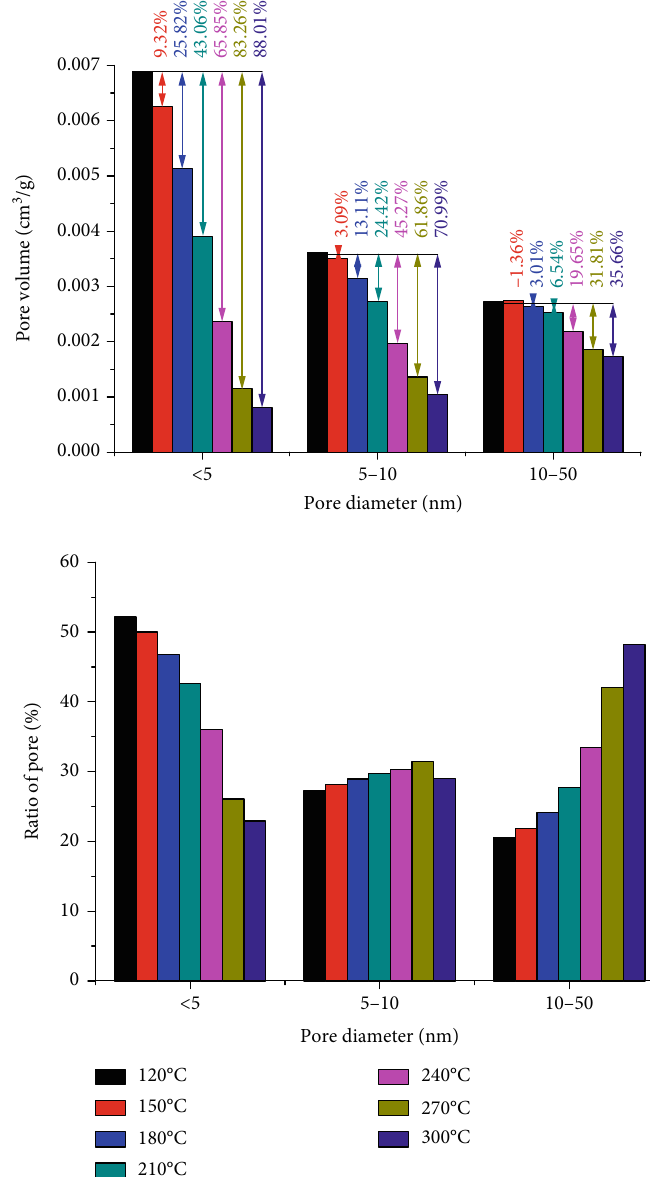
Figure 13: The dynamic change of the PV and ratio of the mesopore with di ff erent pore ranges under various pretreatment